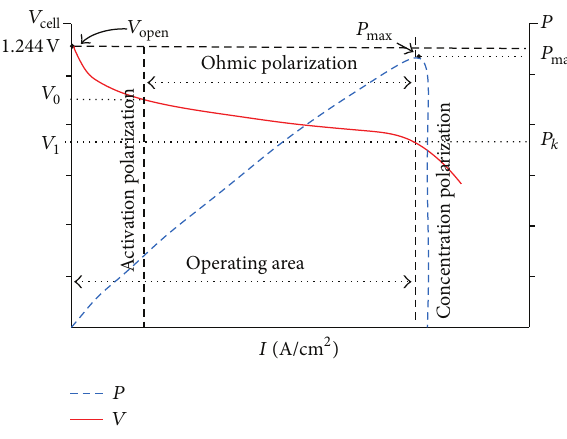
Figure 2: Characteristic curve of Ballard